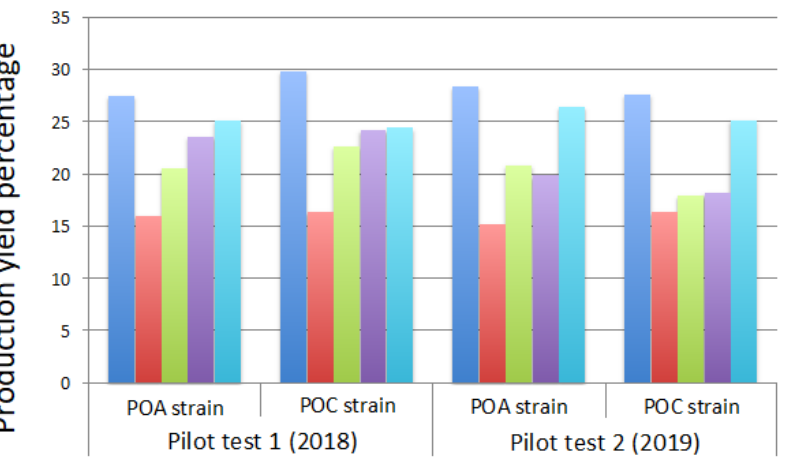
Figure 2. Production yield expressed as the percentage of the two strains grown on different sub- strates (each color refers to different straw/lavender ratios: blue = 100/0; red = 0/100; green = 50/50; violet = 60/40; light blue = 70/30) containing different concentrations of lavender waste in 2018 and 2019.